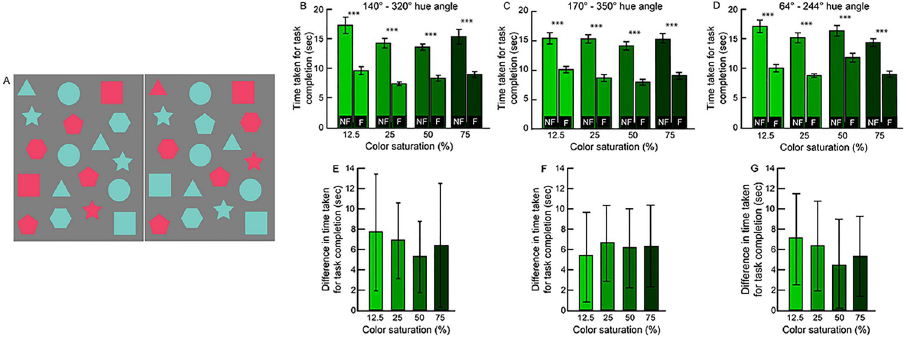
Fig 5. Sample image pair along the red-green color axis (140 – 320o hue angle) with 75% color saturation used in Experiment 3 (Panel A). Mean ( ± 1 SEM) time taken for task completion across target color saturations and hue angles (panels B–D). Mean ( ± 1 SEM) difference in the time taken between the non-fusion (NF) and fusion (F) modes of gameplay for each combination of color saturation and hue angle (panels E–G). Asterisk symbols are same as Fig